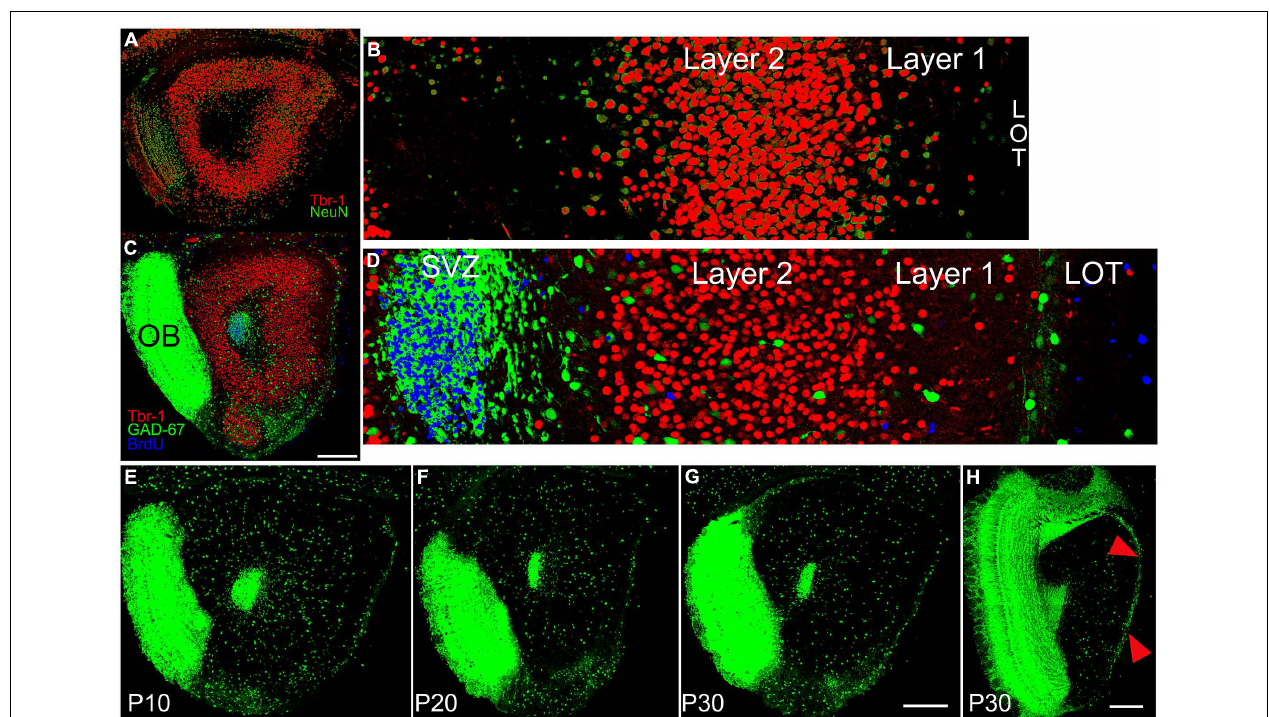
FIGURE 2 | (A) Section from a P10 subject double stained forTbr-1 (red) and NeuN (green) taken at the same level as the diagram in Figure 1C . (B) 350 μ m-wide higher magnification view of the standardized region in the lateral OP.Tbr-1 immunoreactive cells fill Layer 2 of AONpP. Cells staining only for NeuN were found in large numbers in the granule cell layer of the OB ( A , left side) scattered in both Layer 1 and the deep white matter of the core of the peduncle, and occasionally in Layer 2. (C) Section from a P10 GAD67-GFP pup stained forTbr-1 and BrdU (injected 72 h previously). (D) 350 μ m-wide higher magnification view of the standardized region in the lateral OP. Blue BrdU labeling was heavy in the SVZ/RMS with cells also often observed along